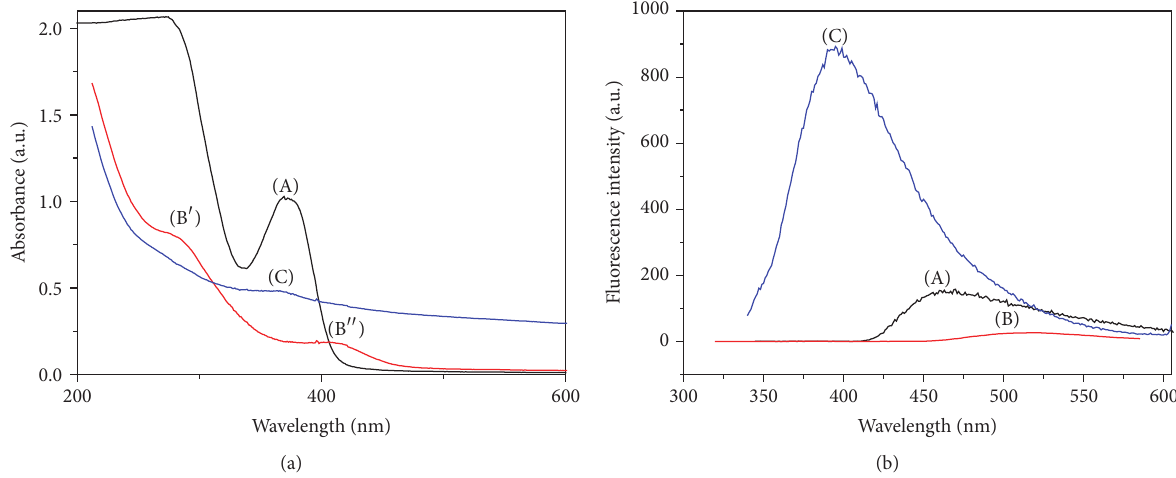
Figure 5: UV-vis spectra (a) and fluorescence spectra (b) of ZnO nanoparticles before and after